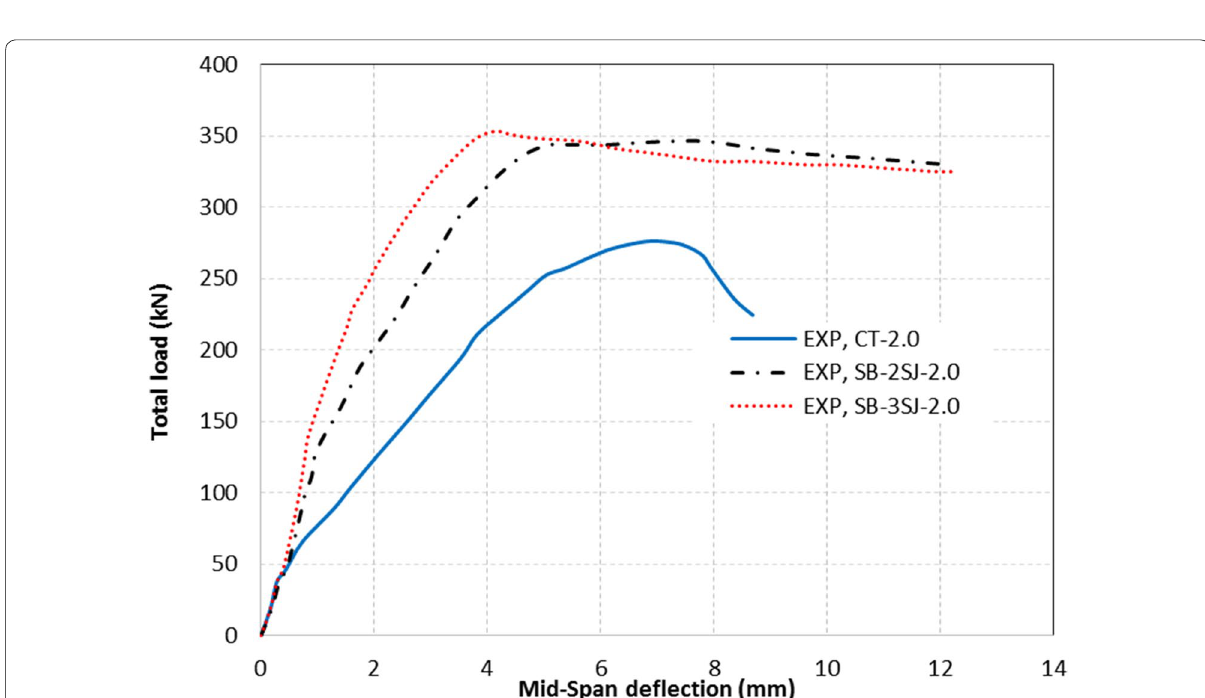
2.0 (a 384 mm) at failure = =